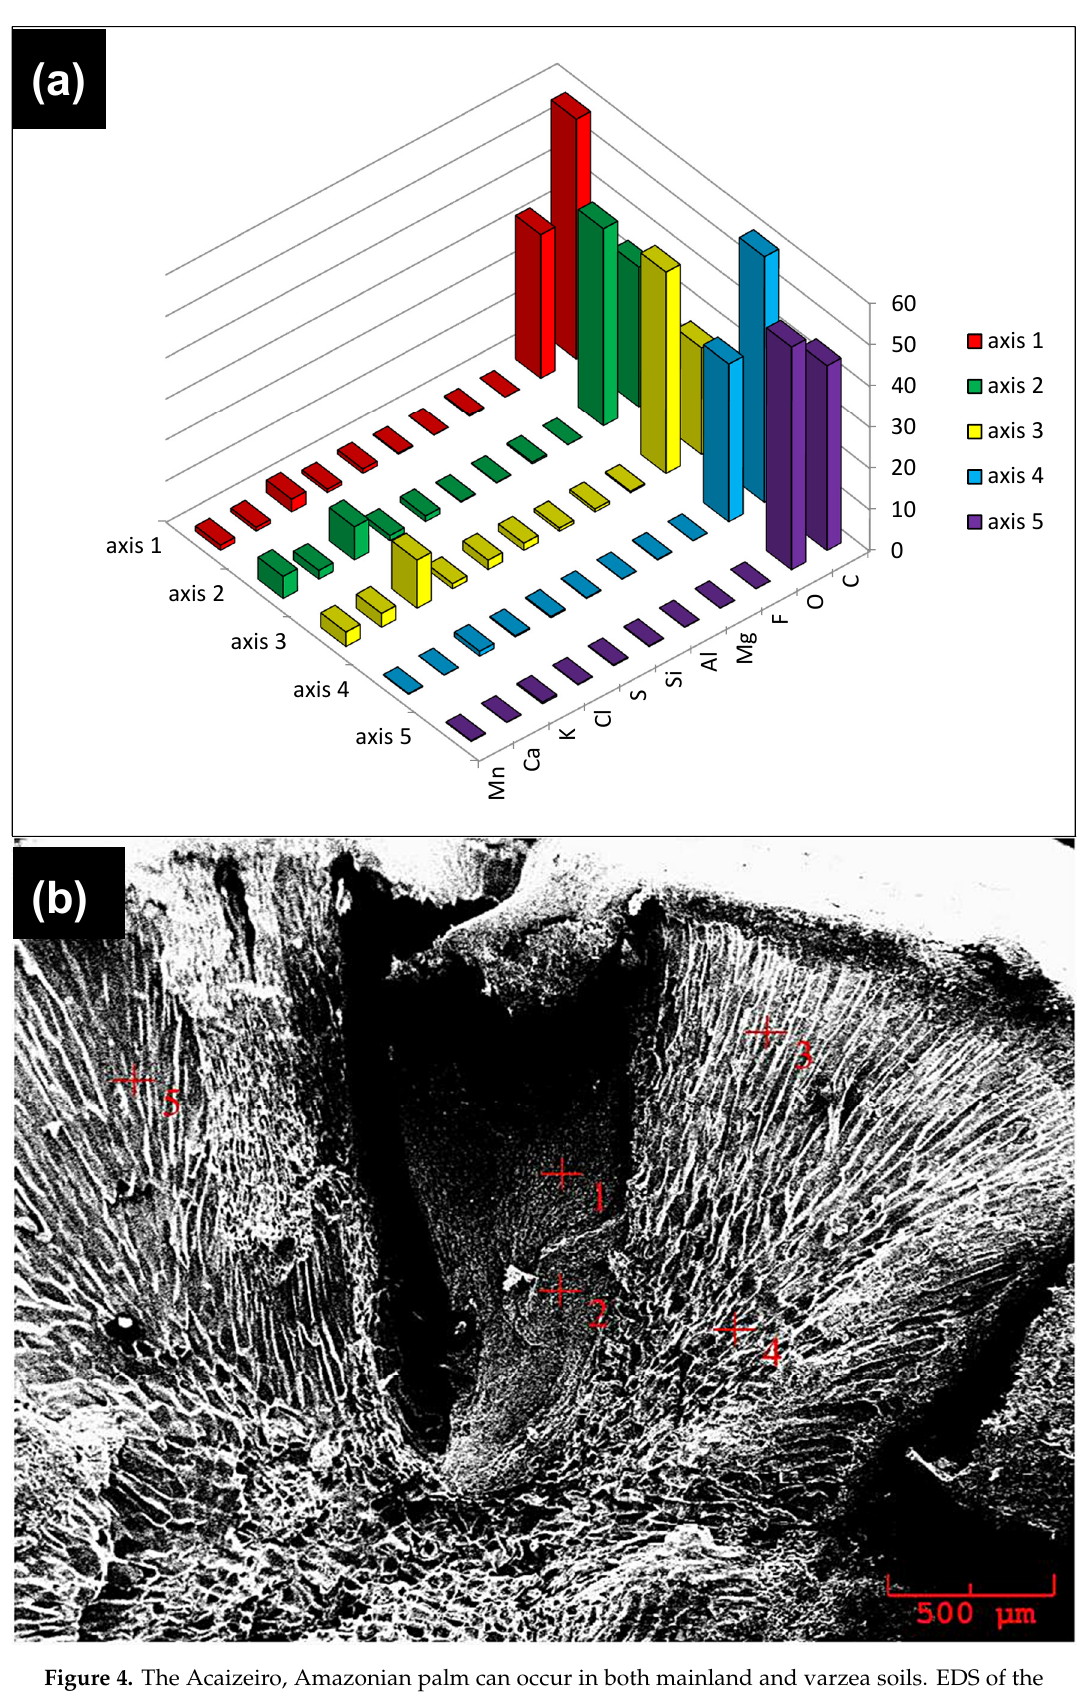
Figure 4. The Acaizeiro, Amazonian palm can occur in both mainland and varzea soils. EDS of the várzea soil açaí seed ( a ) and SEM of the várzea soil açaí seed ( b ).